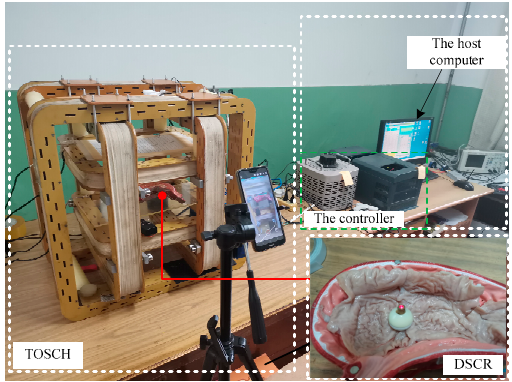
Figure 15. The experiment platform of the control system of the URMF.